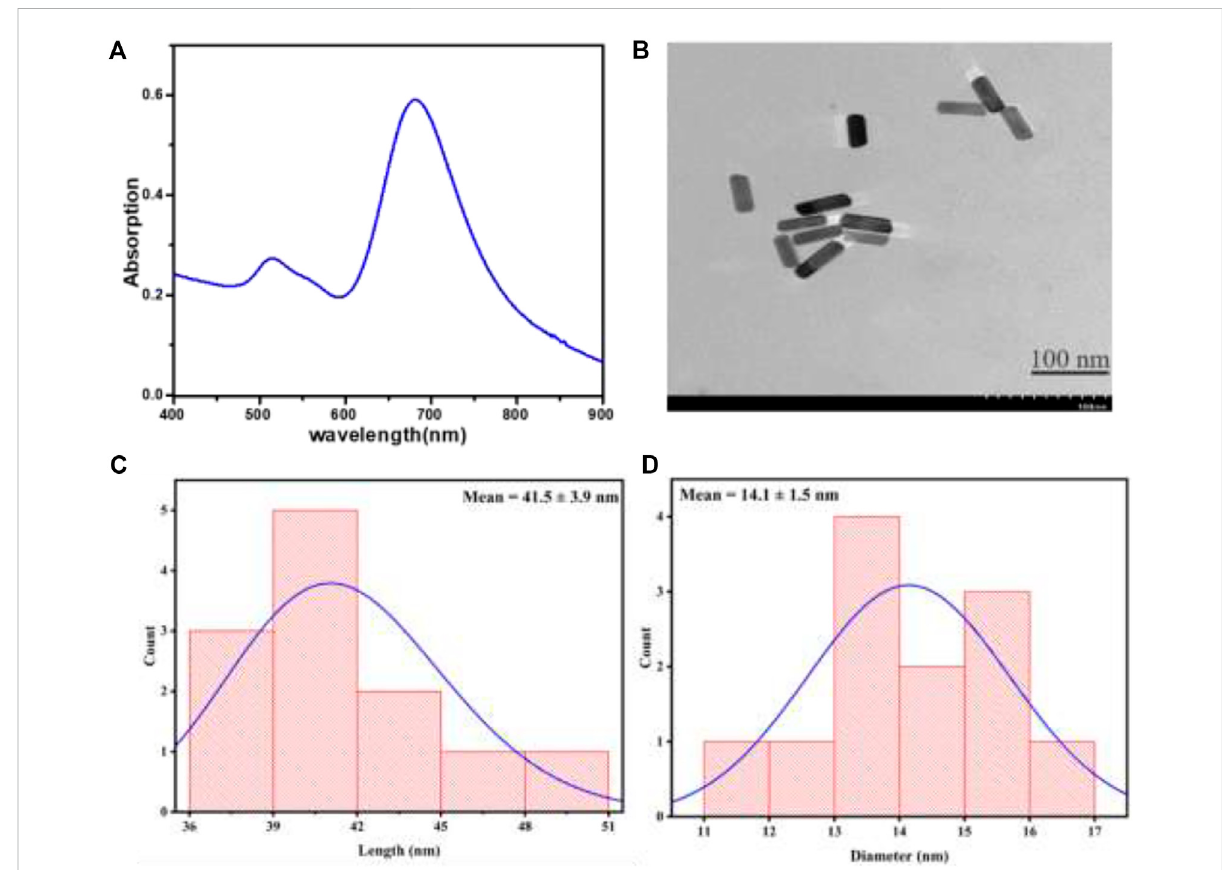
FIGURE 2 (A) TheUV-vis spectrumofGNRsinaqueousmedium (B) TEMimageofGNRsdemonstratinggoodsizeuniformity.The histogram fi guresshow the (C) length and (D) diameter of GNRs from TEM